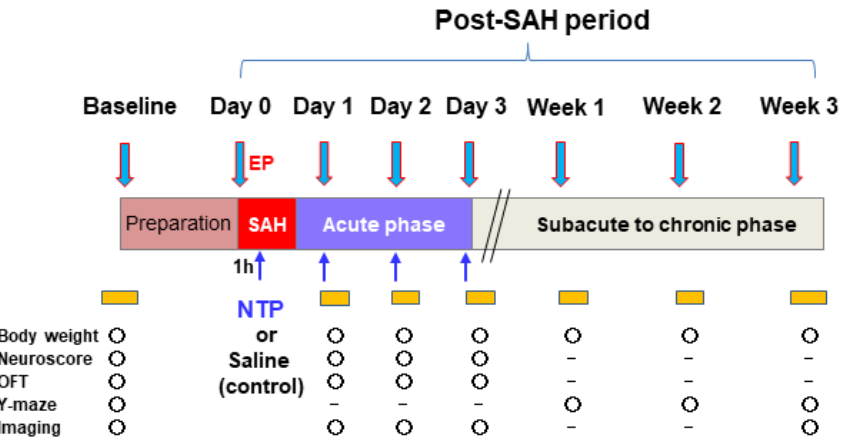
Figure 1. Experimental protocol EP, endovascular perforation, to create SAH. NTP, neurotropin; OFT, open-field test.